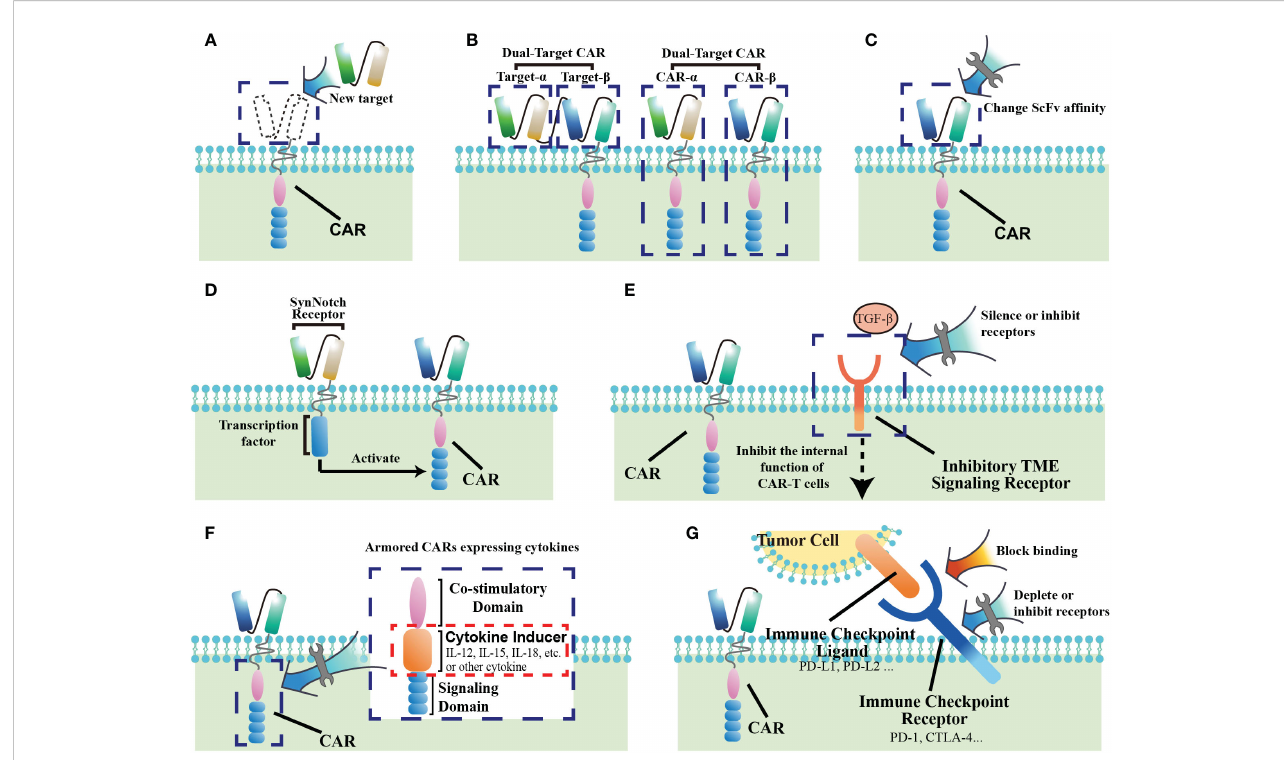
FIGURE 3 Methods of improving CAR-T cell therapy for solid tumors. (A) Find new targets with better speci fi city. (B) Construct dual-target CARs. (C) Change the af fi nity of the extracellular ScFv segment of CAR. (D) Construct SynNotch-receptor switch. (E) Block receptors of the inhibitory signaling from the tumor microenvironment (TME). (F) Armored CARs with cytokines. (G) Prevent CAR-T cell exhaustion through immune